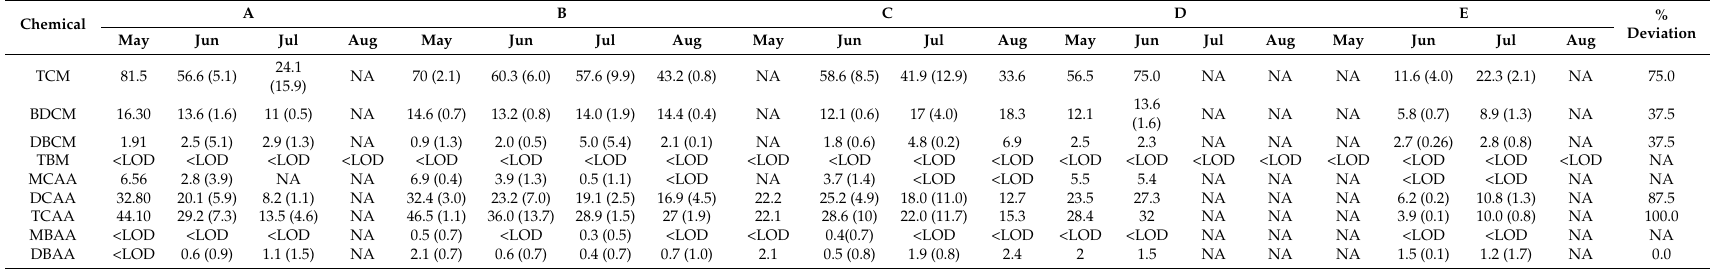
Table 4. Temporal variability of individual THMs and HAAs for all surface water